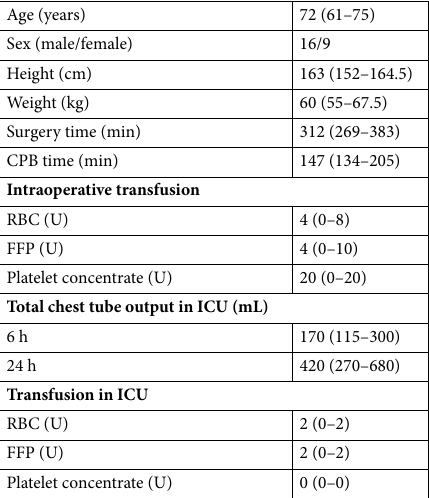
Table 2. Patient demographics, transfusion, and postoperative blood loss (n = 25). Data are expressed as medians and quartiles (Quartile 1, Quartile 3). Volume of product per unit (U): Red blood cell (RBC), 140 mL/U; Fresh frozen plasma (FFP), 120 mL/U; (apheresis) Platelet concentrate, 250 mL/20U. CPB cardiopulmonary